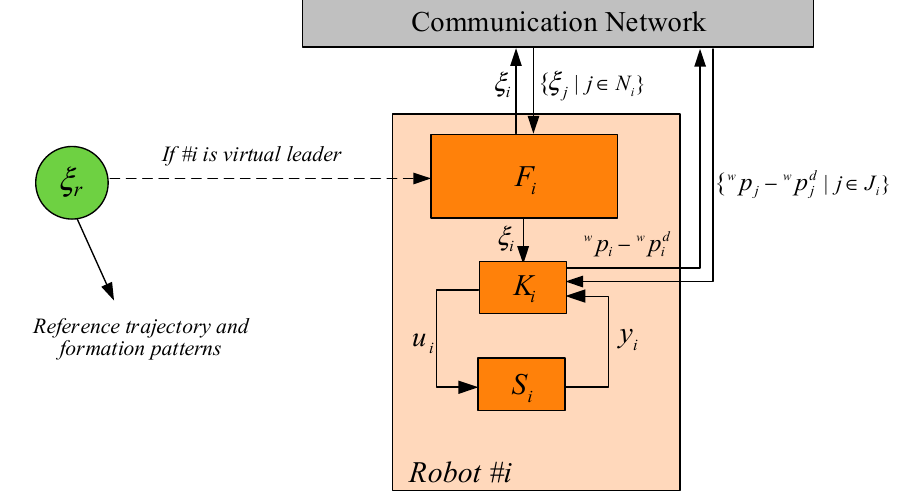
Figure 3. Decentralized virtual linkage architecture.